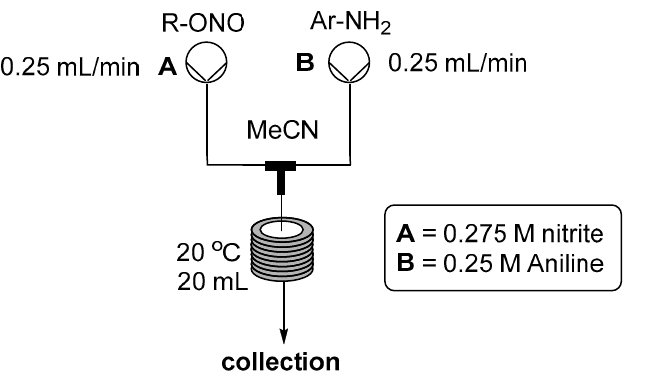
Figure 5. Flow reactor for diazonium formation under anhydrous conditions (material not isolated Flow reactor for diazonium formation under anhydrous conditions (material not —anion not determined). isolated—anion not